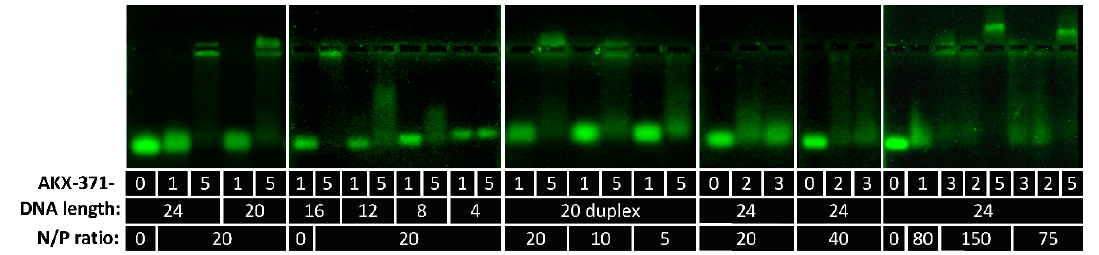
Figure 3. Gel electrophoresis data for AKX-371-N (N = 1, 2, 3, 5) complexes with DNA. “0”–free DNA (similar blots were observed irrespective of DNA length). DNA concentration was 2.5 µM (calculating on DNA chains). Table 4. Interaction of si-RNA with LCPA containing polymers.